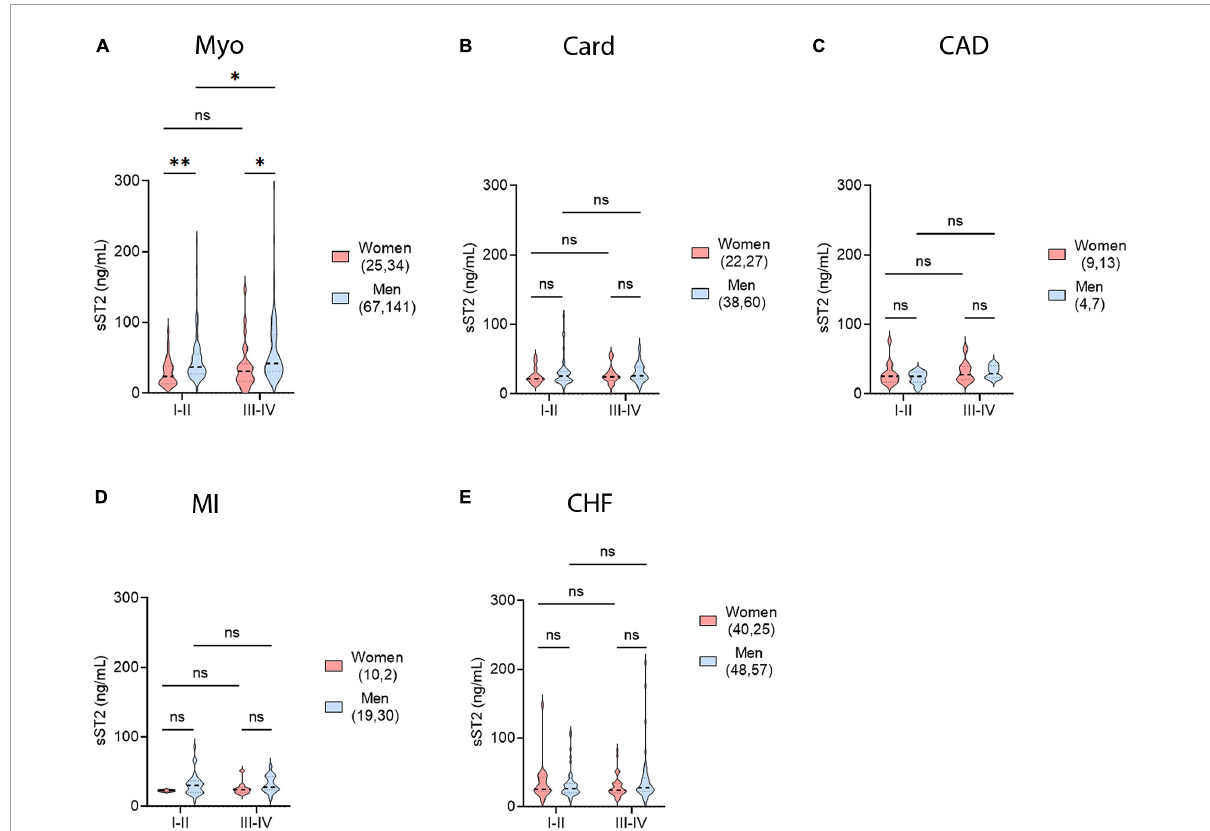
FIGURE9 Sex differences in NYHA class and sST2 levels. sST2 levels compared women and men (gray), women (peach), or men (blue) to New York Heart Association (NYHA) class I–II vs. III–IV heart failure for (A) myocarditis (Myo), (B) cardiomyopathy (Card), (C) coronary artery disease (CAD), (D) myocardial infarction (MI), or (E) congestive heart failure (CHF). Violin plots denote data distribution for each group. One-way ANOVA: (A) p = 0.0002, (B) p = 0.66, (C) p = 0.64, (D) p = 0.55, and (E) p = 0.28. (A) Two-way ANOVA p -values indicate no interaction between NYHA Class and sex ( p = 0.59) in patients with myocarditis, but interactions between NYHA Class and sST2 ( p = 0.04) and sex and sST2 ( p = 0.0002). (B) Two-way ANOVA p -values indicate no interactions between NYHA Class and sex ( p = 0.94), NYHA Class and sST2 ( p = 0.74), or sex and sST2 ( p = 0.22) in patients with cardiomyopathy. (C) Two-way ANOVA p -values indicate no interactions between NYHA Class and sex ( p = 0.63), NYHA Class and sST2 ( p = 0.32), or sex and sST2 ( p = 0.52) in patients with CAD. (D) Two-way ANOVA p- values indicate no interactions between NYHA Class and sex ( p = 0.75), NYHA Class and sST2 ( p = 0.80), or sex and sST2 ( p = 0.20) in patients with MI. (E) Two-way ANOVA p -values indicate no interactions between NYHA Class and sex ( p = 0.12), NYHA Class and sST2 ( p = 0.72), or sex and sST2 ( p = 0.40) in patients with CHF. *, p < 0.05; **, p <